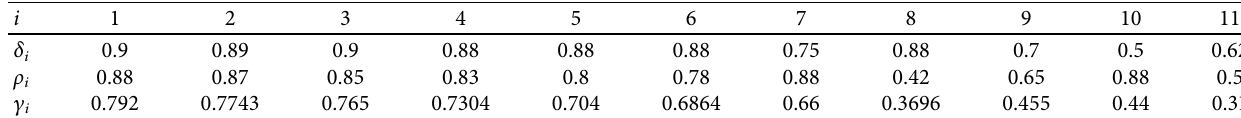
Figure 1: Sample dataset of the DPC algorithm and its decision graph [10]. Table 2: Partial data points of a sample